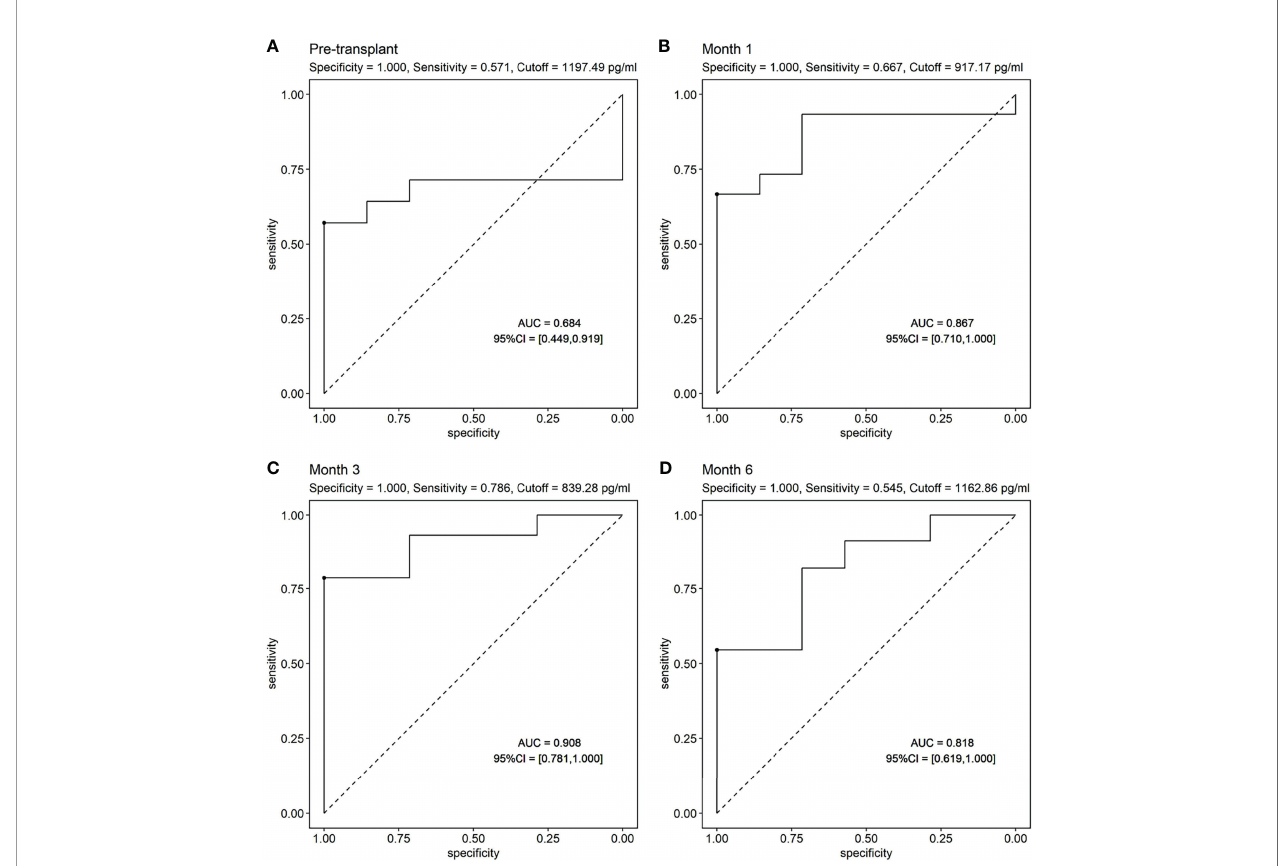
FIGURE 5 | The receiver operating characteristic (ROC) curves of soluble B cell-activating factor (sBAFF) levels at different time points in predicting the donor speci fi c antibody (DSA). (A) The ROC curve of pretransplant sBAFF levels to predict the dnDSA. The pretransplant sBAFF levels had no predictive value for dnDSA. (B – D) The ROC curve of sBAFF levels at M1, M3 and M6 to predict the dnDSA. The sBAFF levels at M3 had the biggest AUC (0.908), with a good sensitivity (0.786) and speci fi city when the threshold was 839.28